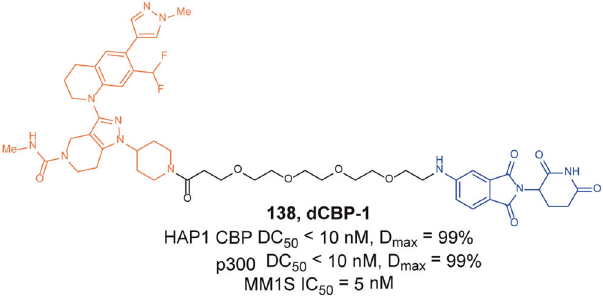
Fig. 31 The representative PROTAC targeting CBP and p300